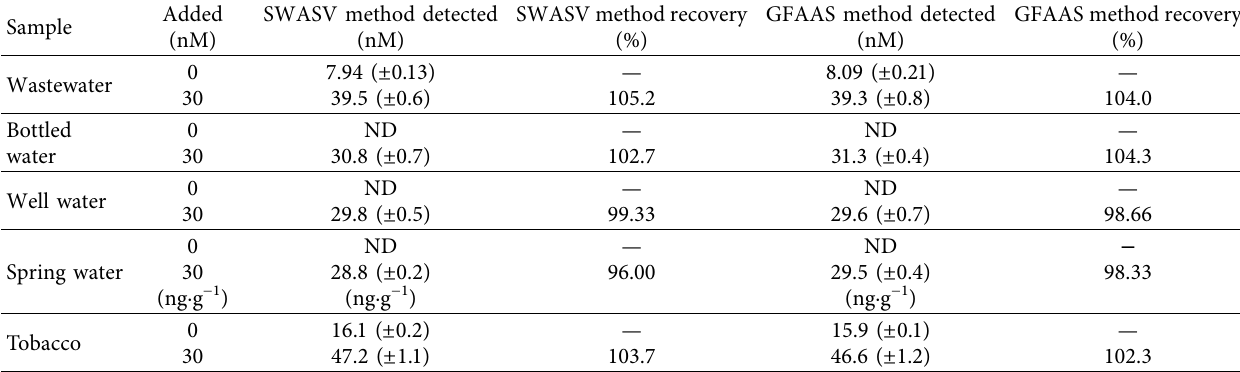
Table 4: Results of determination of Cd(II) in the real samples using the developed method ( n � 5) and GFAAS method.